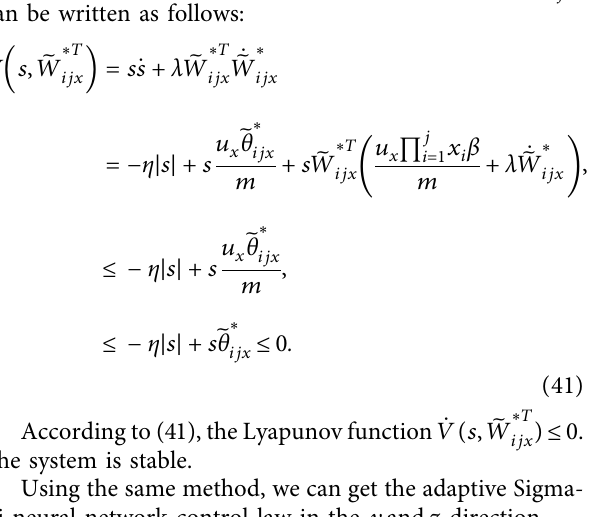
Table 1: Parameters of the quadrotor.